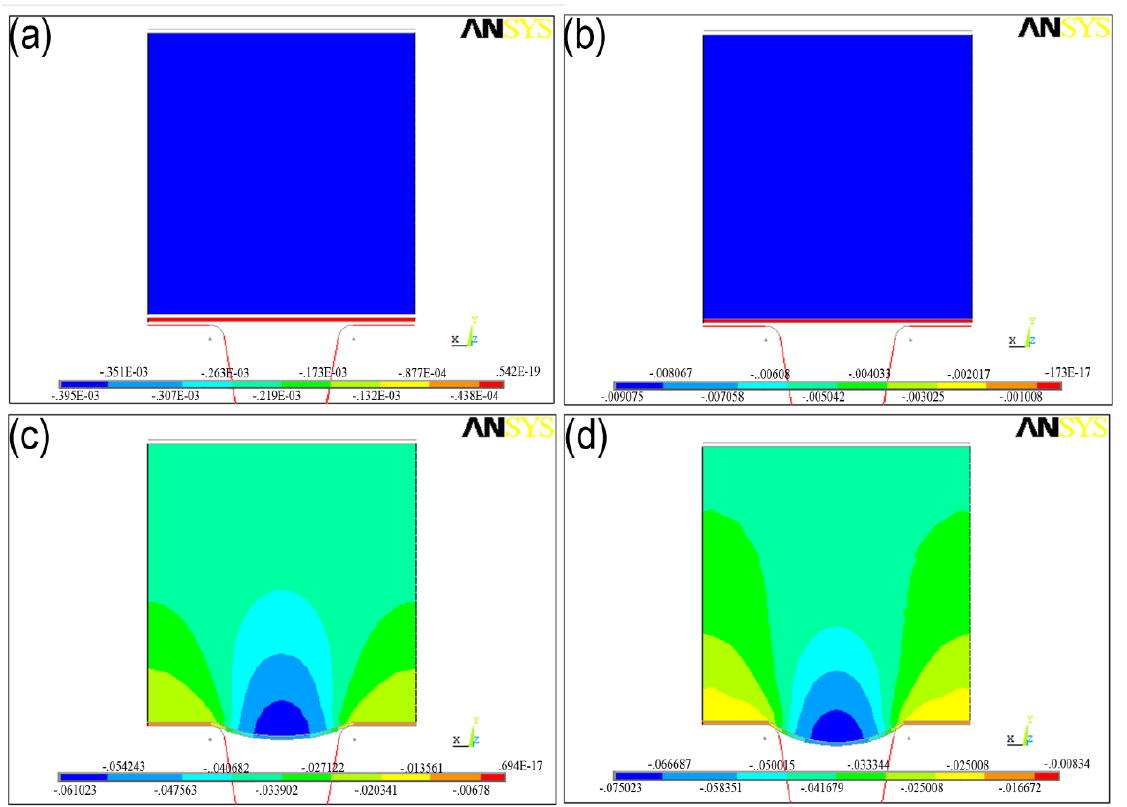
Figure 10. The typical stages of deformations with contours of Y-displacement distribution